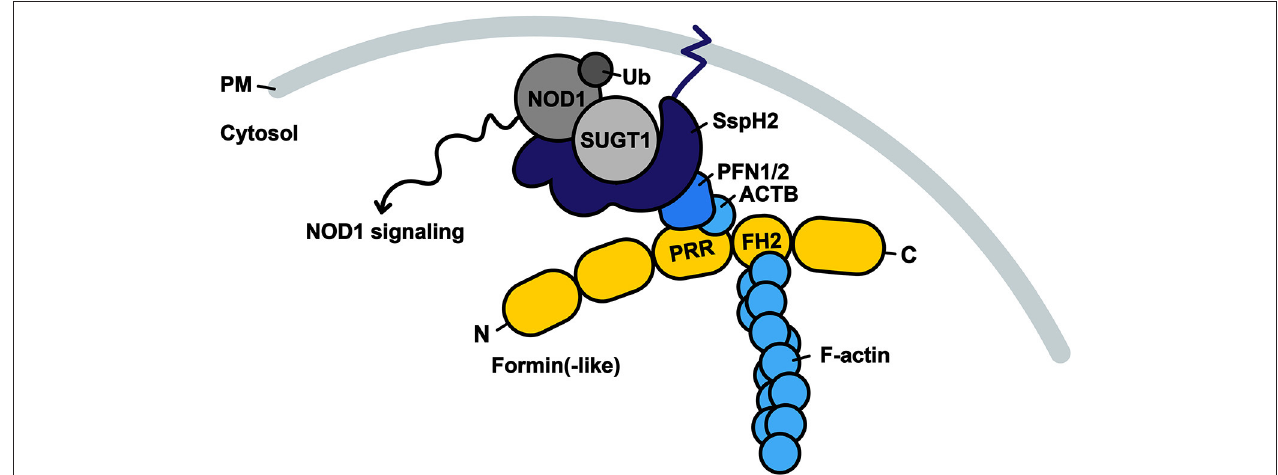
FIGURE 6 | Model of SspH2 resulting in SUGT1-dependent NOD1 signaling at the dynamic actin cytoskeleton. SspH2 is localized to the plasma membrane (PM) by S -palmitoylation (dark blue zigzag line). Subsequent interaction with profilins (PFN1 and − 2) specifies the localization of effector SspH2 further toward polymerizing actin filaments as a result of profilin binding to proline-rich regions (PRRs) of formin(-like) proteins (yellow), such as DIAPH1 and FMNL2. Barbed ends of actin filaments are bound to formins through formin-homology domains (FH2). SspH2 localized at the actin cytoskeleton allows for NOD1 signaling upon SUGT1 binding and E3 ubiquitin ligase activation. Proteins in greyscale represent proteins that were not (significantly) enriched as SspH2 interactors using Virotrap. Interactors in shades of blue were previously reported and significantly enriched in the Gag-SspH2 Virotrap samples.